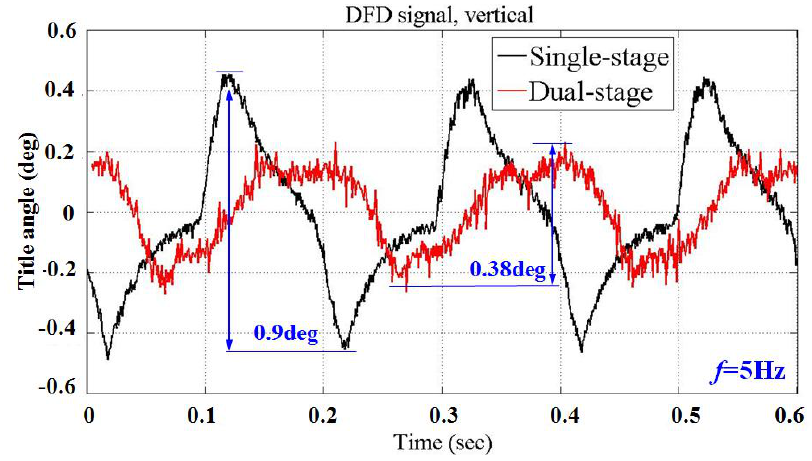
Figure 21. Experimental verification of dual stage compensation: with (red line) and without (black line) piezo-actuated stage